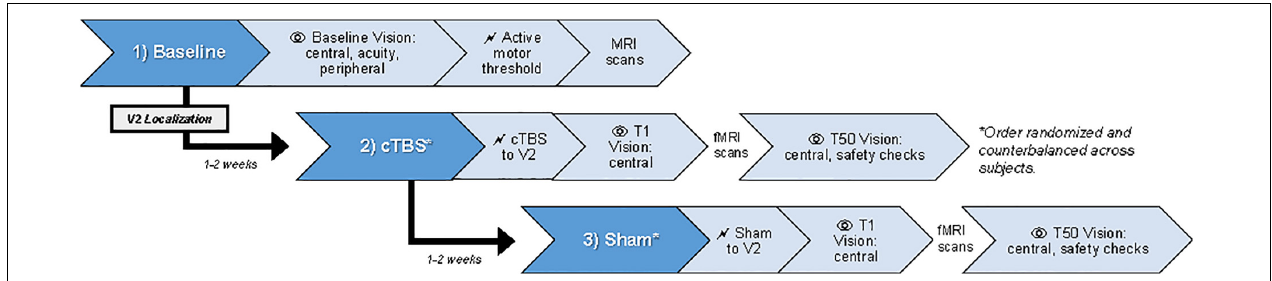
FIGURE 1 | Overview of study procedures. Participants completed three sessions: baseline, cTBS, and sham-cTBS. Session order was randomized and counterbalanced across participants. T1 and T50, 1- and 50-min post-stimulation; cTBS, continuous theta burst stimulation; V2, secondary visual cortex. MRI scans were collected on Day 1 to guide target selection and TMS neuronavigation during subsequent visits. Note that the fMRI scans/tasks were unrelated to the research question being addressed in this paper (whether cTBS applied to V2 at 80% AMT causes blind spots) and thus are outside the scope of the present paper and will be reported